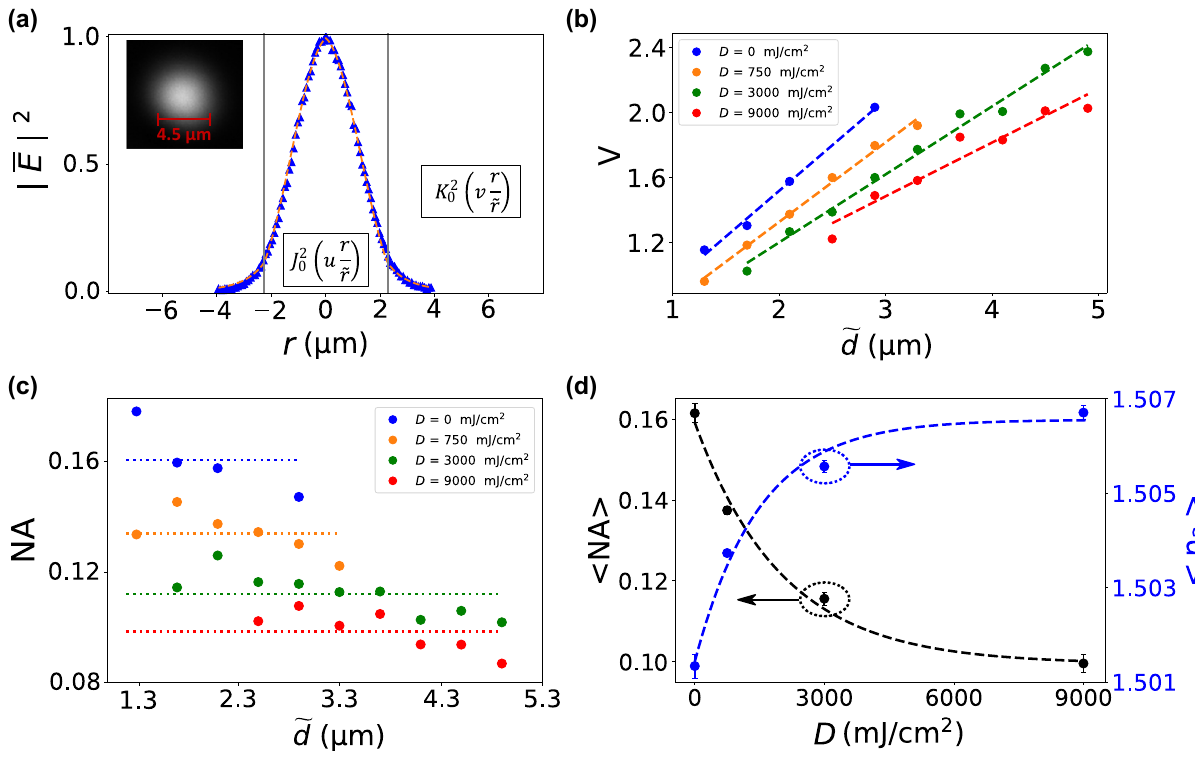
Figure 3: Modal confinement of 3D-printed waveguides cured via blanket UV exposure. (a) Output intensities (blue triangles) and fundamental LP 01 mode fi t (dashed orange lines) of d ̃ = 4 . 5 μ m waveguide cured with D = 3000 mJ/ cm 2 .(b)Normalizedfrequency V versuseffectivediameter d ̃ ,OPPcuringwith0 (bluedots),750(orange),3000(green)and9000(red)mJ/cm 2 . Dashed lines indicate the linear regression of the experimental data. (c) Numerical aperture NA values versus effective waveguide d ̃ dependence. Dashed lines represent the average 〈 NA 〉 for each UV dose D . (d) 〈 NA 〉 (black) and ⟨ n 2 ⟩ (blue) versus UV dose. Dashed lines indicate the exponential fi t to experimental